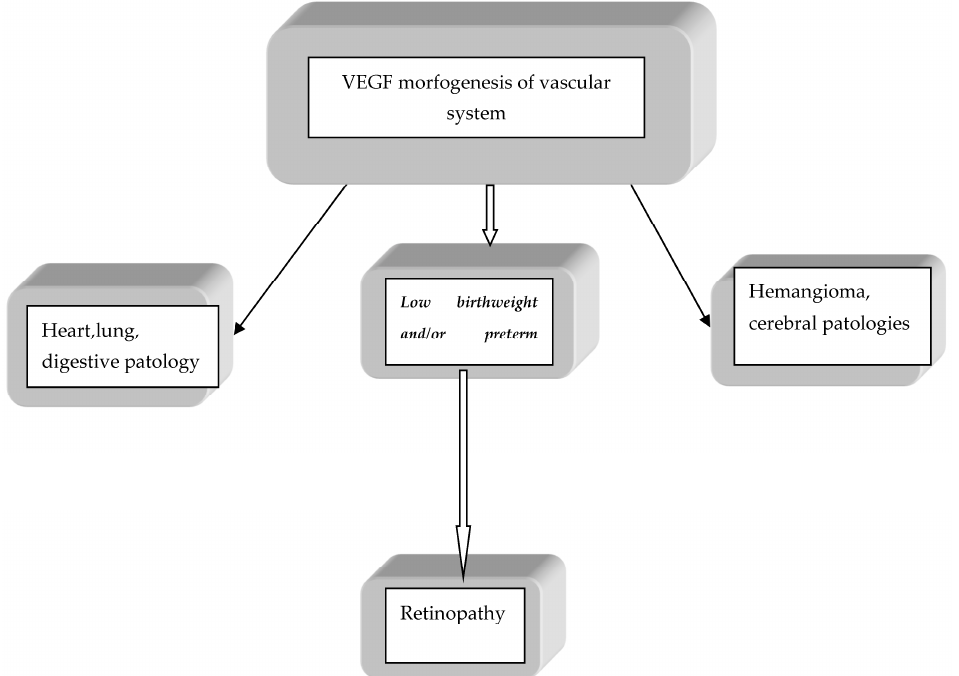
Figure 1. Link between VEGF polymorphism and neonatal pathology .